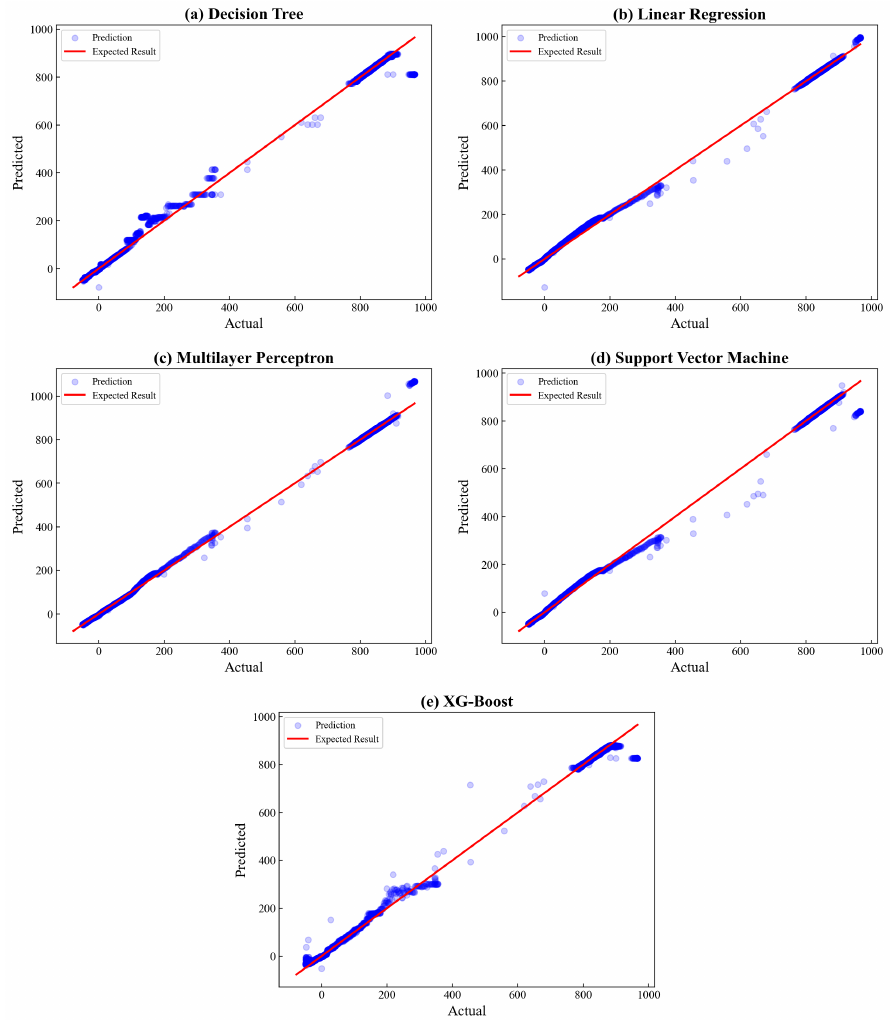
Figure 10. Actual vs. predicted plot of Combustion